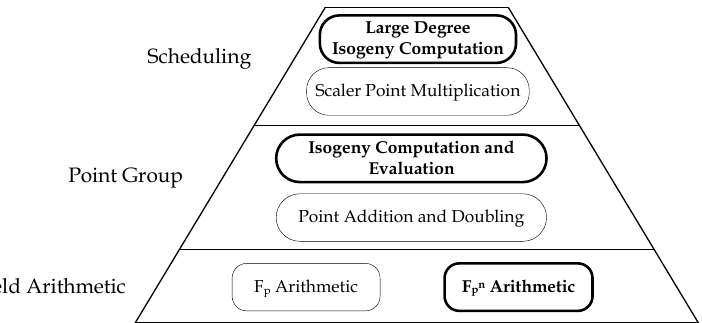
Figure 3. Underlying operations for supersingular isogeny cryptography and ECC.